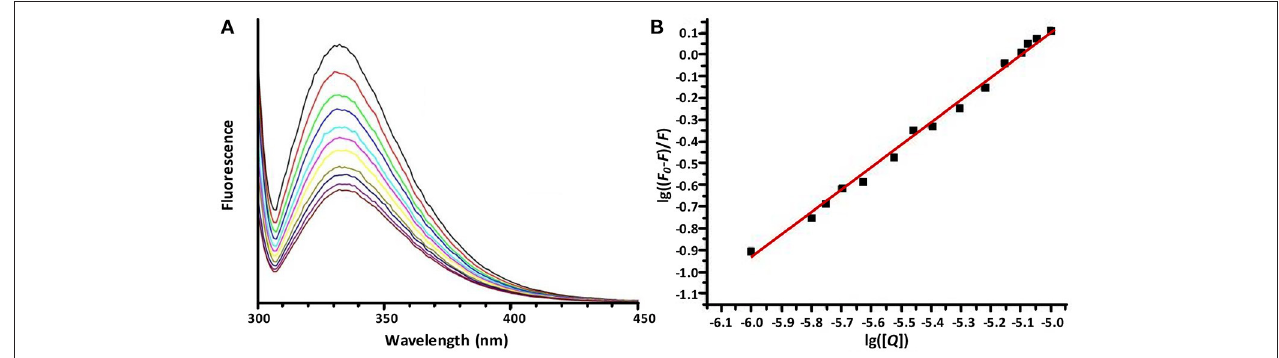
FIGURE 5 | The emission spectra of OVA (10.0 µ M) in sodium phosphate buffer (10mM, pH 7.4) in the presence of increasing concentrations of Hf1-WD2. (A) demonstrates dependence of the emission fluorescence spectra (from top to bottom) from the concentration of Hf1-WD2, which was increased stepwise from 0 to 10 µ M. All spectra were recorded from 300 to 420nm while the sample was excited at 295nm. The spectra are dominated by the Trp fluorescence with a maximum at around 337nm. (B) displays the plot of the Stern-Volmer equation (with R 2 = 0.976) that represents the quenched maximum fluorescence (lg(( F-F 0 )/ F )) in function of the logarithm of the concentration of the quencher (lg[ Q ]). From the plot, K q and n were calculated to be 1.1 × 10 5 M − 1 and 0.85,